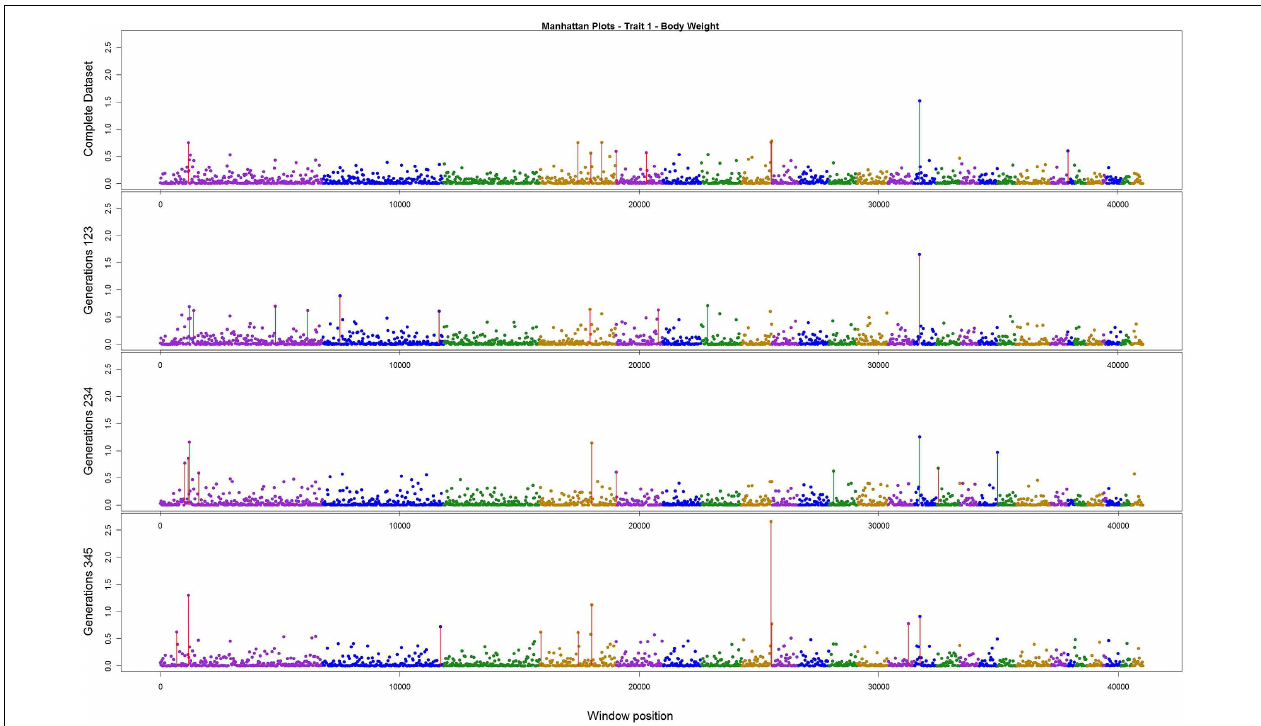
FIGURE 2 | Manhattan plots for percentage of variance explained for Body weight, performed for all the data set, and the subsets of generations.